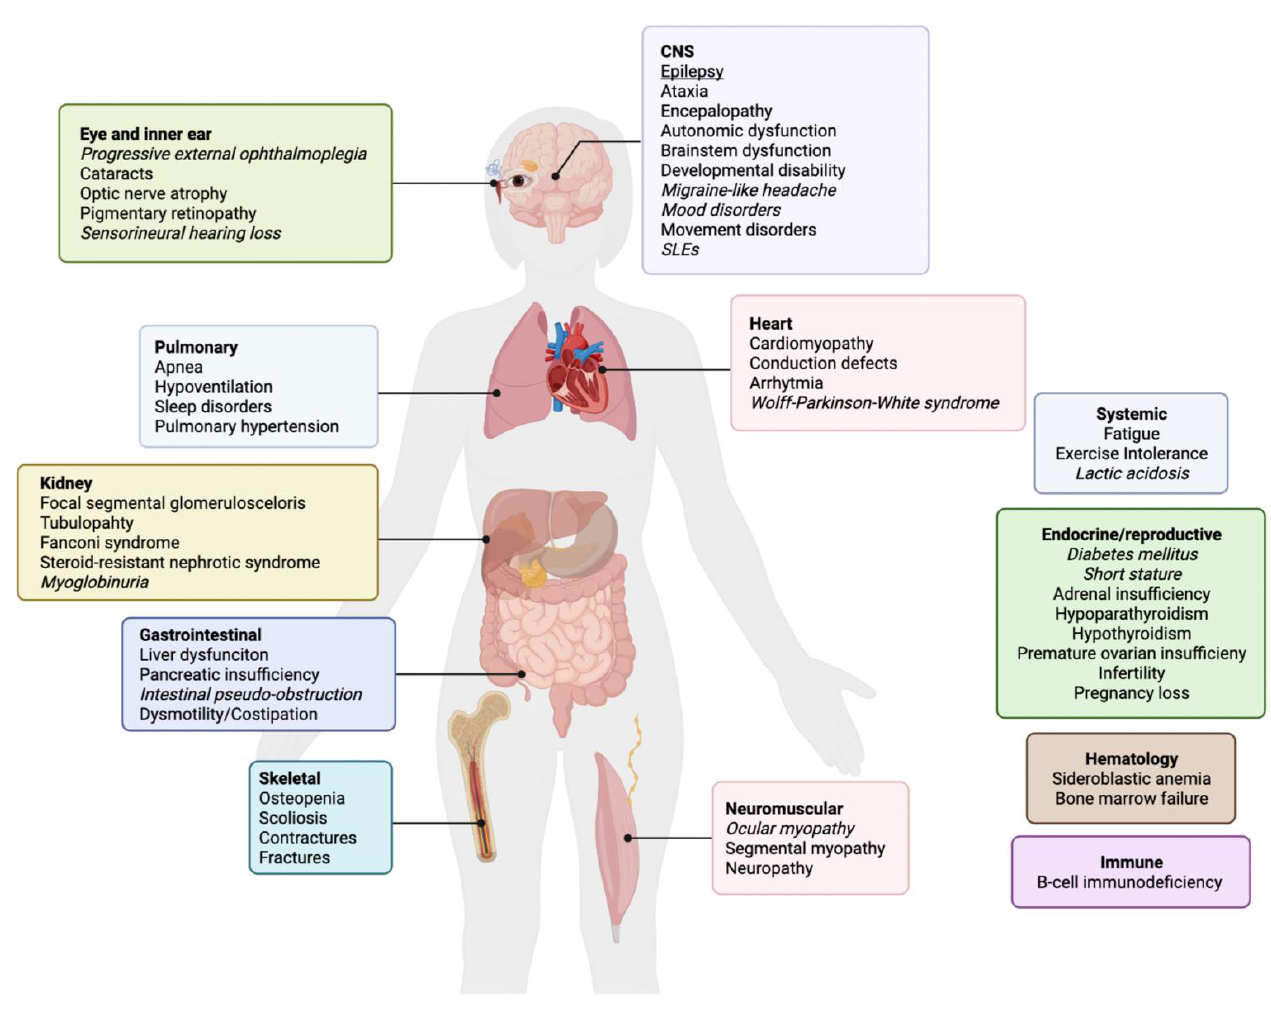
Figure 2. Phenotypic expression of primary mitochondrial diseases. In italics: peculiar signs/symptoms (‘red flags’) suggestive of mitochondrial disorder.